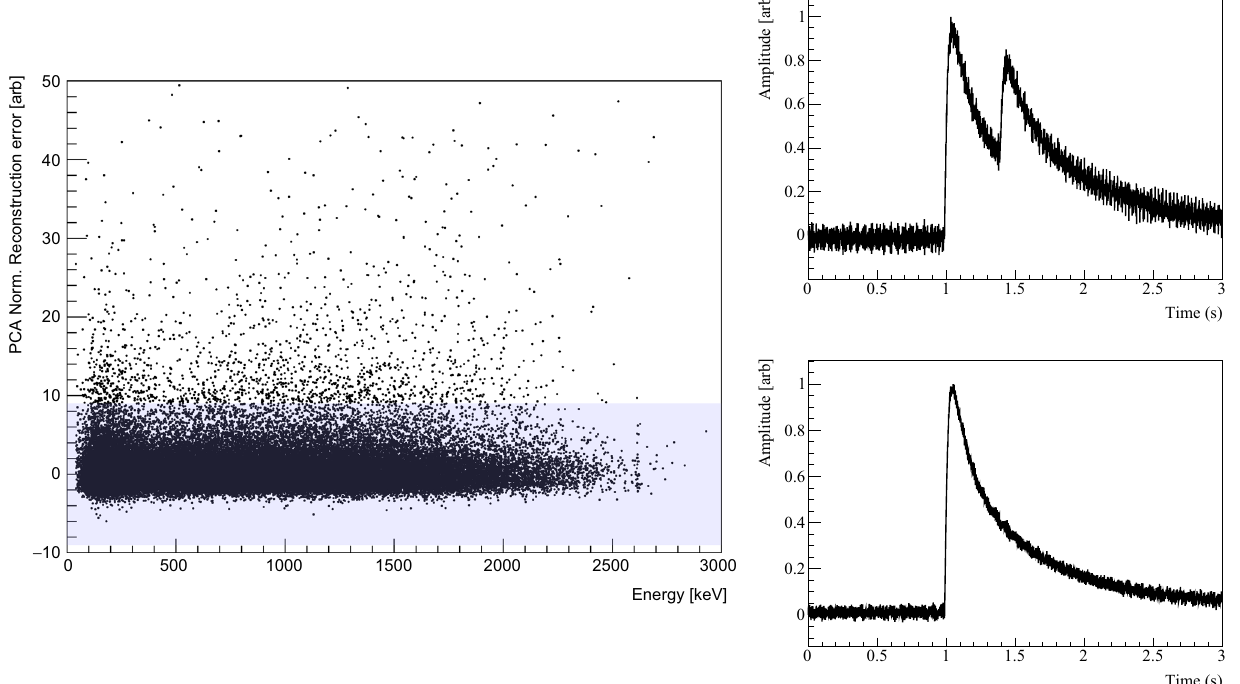
Fig. 5 Example of the normalized PCA reconstruction error (left) as a function of energy, and two types of events (right) that exist in our data. (Left:) The normalized reconstruction errors have no energy depen- dence and are normalized on a run-by-run basis for each channel allow- ing for a single energy independent cut to be applied across all channels in every dataset. Events with higher normalized reconstruction errors are removed and likely have incorrect energy values which may cause such events to be shifted into the region of interest. The shaded box